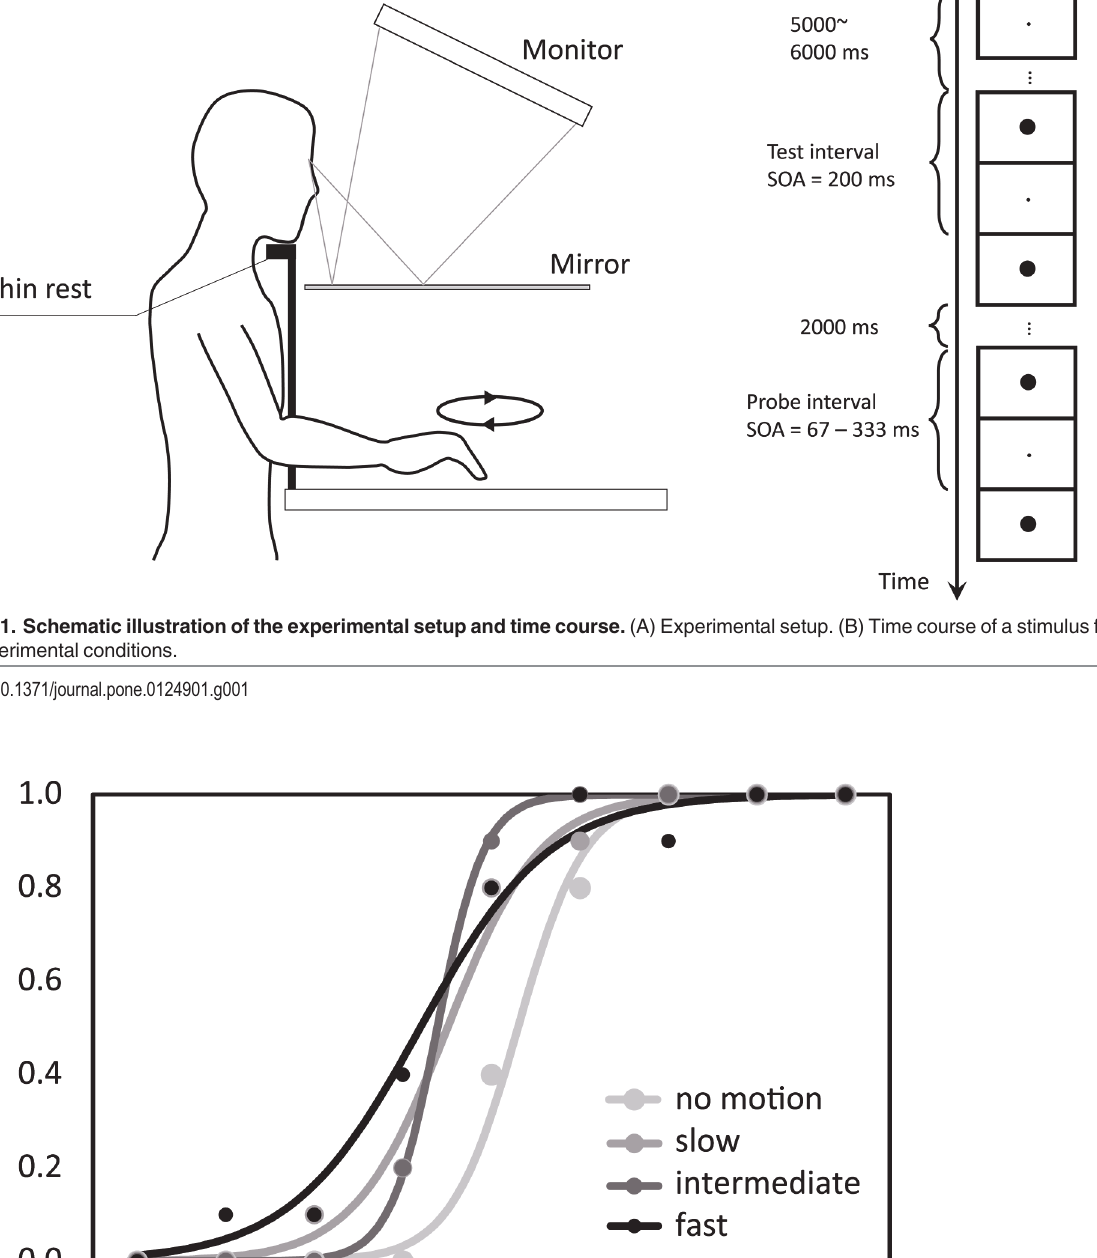
PLOS ONE | DOI:10.1371/journal.pone.0124901 April 8, 2015 3 /